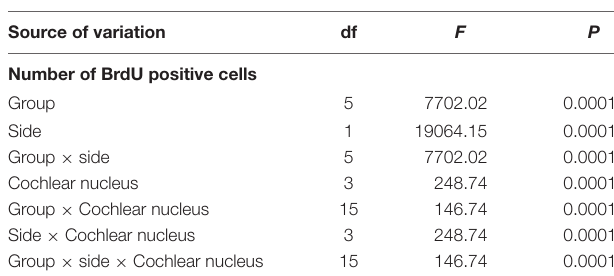
TABLE 1 | Statistical analysis of the effects of unilateral cochlear neurectomy (UCN) on the time course of cell proliferation in the cochlear nuclei complex of adult